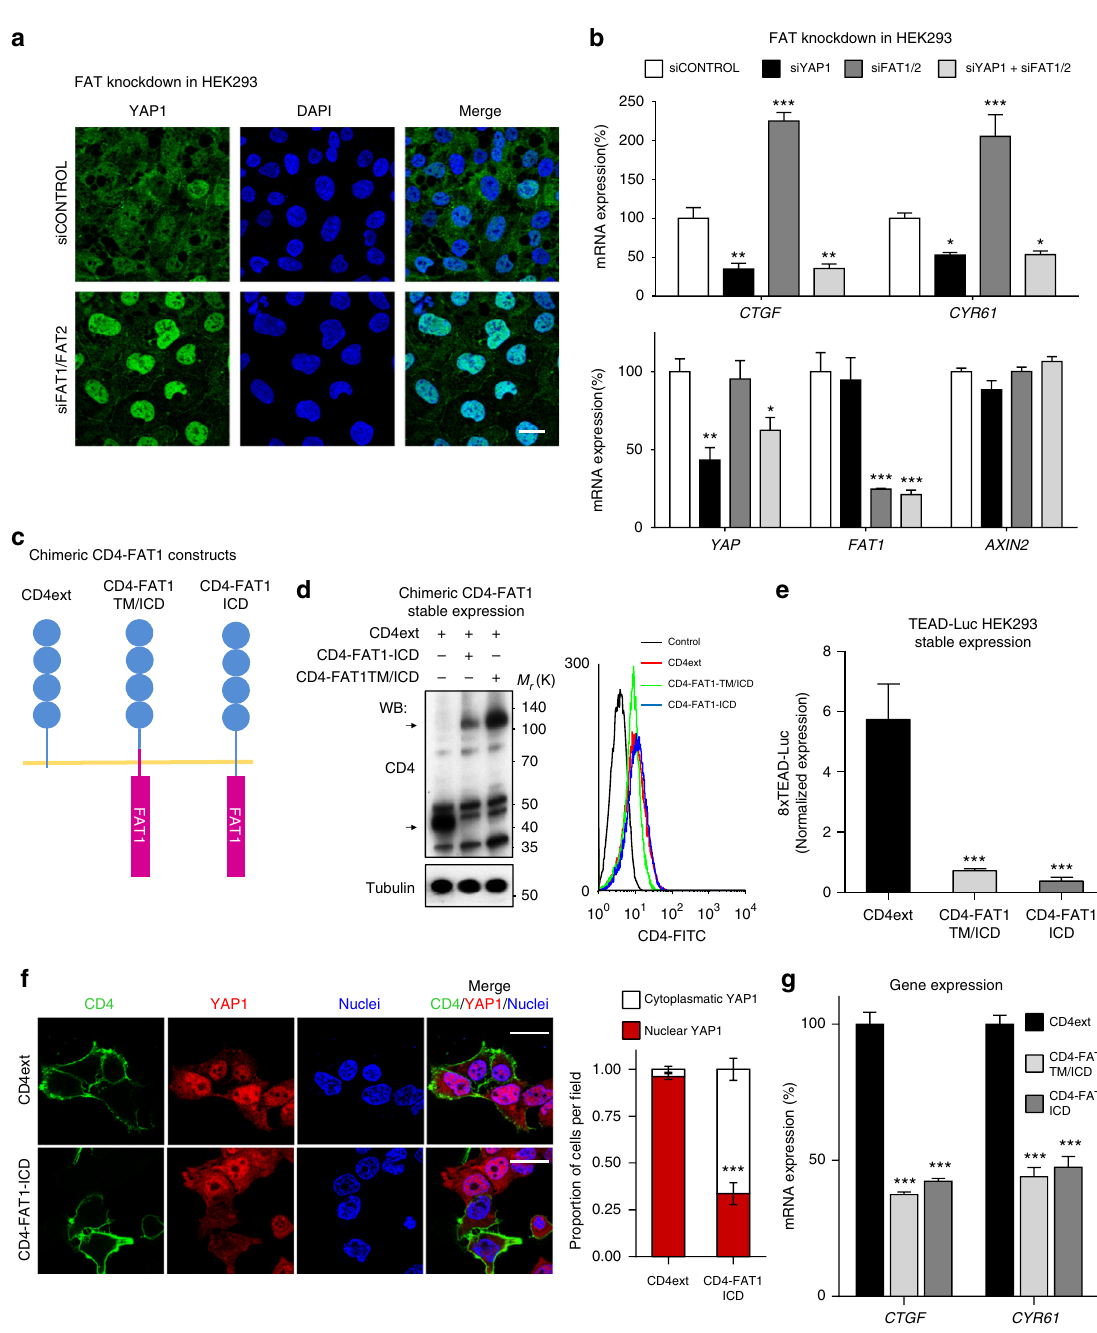
Fig. 2 FAT1 regulates YAP1 nuclear localization and activity. a siRNA-mediated knockdown of FAT1 and FAT2 in HEK293 cells induces the accumulation of nuclear YAP1 as depicted by immuno fl uorescence and its associated quanti fi cation. In green (Alexa 488), YAP1 staining and in blue, the nuclear counterstain DAPI. A representative experiment is shown. Scale bar, 25 µ m. b Knockdown of FAT1 and FAT2 induces the upregulation of the YAP1 targets CTGF and CYR61 in HEK293 cells in a YAP1-dependent manner. Gene expression analysis of HEK293 cells transiently transfected with siRNAs against control (scrambled), YAP1, FAT1, and FAT2 as indicated. mRNA levels were evaluated by quantitative PCR (qPCR). Bars represent the GAPDH-normalized mean ± SEM ( N = 3). c Schematic representation of the CD4-FAT1-ICD chimeric constructs. d Expression and correct plasma membrane localization of the CD4 chimeras by western blot and FACS. Arrows indicate the speci fi c CD4-chimera bands. Predicted molecular weights CD4ext 46 kDa and both CD4- FAT1 91 kDa . e TEAD-Luciferase reporter assay in HEK293 cells stably transfected with the CD4-FAT1 chimeric constructs. Luciferase expression was evaluated in exponentially growing cultures 36 h after transfection. Bars represent mean Renilla-normalized luciferase expression ± SEM ( N = 4). f Transient overexpression of CD4ext and CD4-FAT1-TM/ICD induces YAP1 nuclear exclusion in HEK293 cells 24 h after transfection. A representative immuno fl uorescence is shown. The nuclear or cytoplasmatic localization of YAP1 was visually evaluated in at least 100 transfected CD4 positive cells from three independent experiments and their quanti fi cation is shown in the right panel. Bars represent mean proportion ± SEM of the nuclear and cytoplasmatic localization of YAP1. Scale bar, 20 µ m. g Quantitative PCR depicting gene expression levels of the YAP1 transcriptional targets CTFG and CYR61 in HEK293 stably expressing CD4-FAT1 ICD constructs. Bars represent the GAPDH-normalized mean ± SEM ( N = 3). * P < 0.05, ** P < 0.01, *** P <